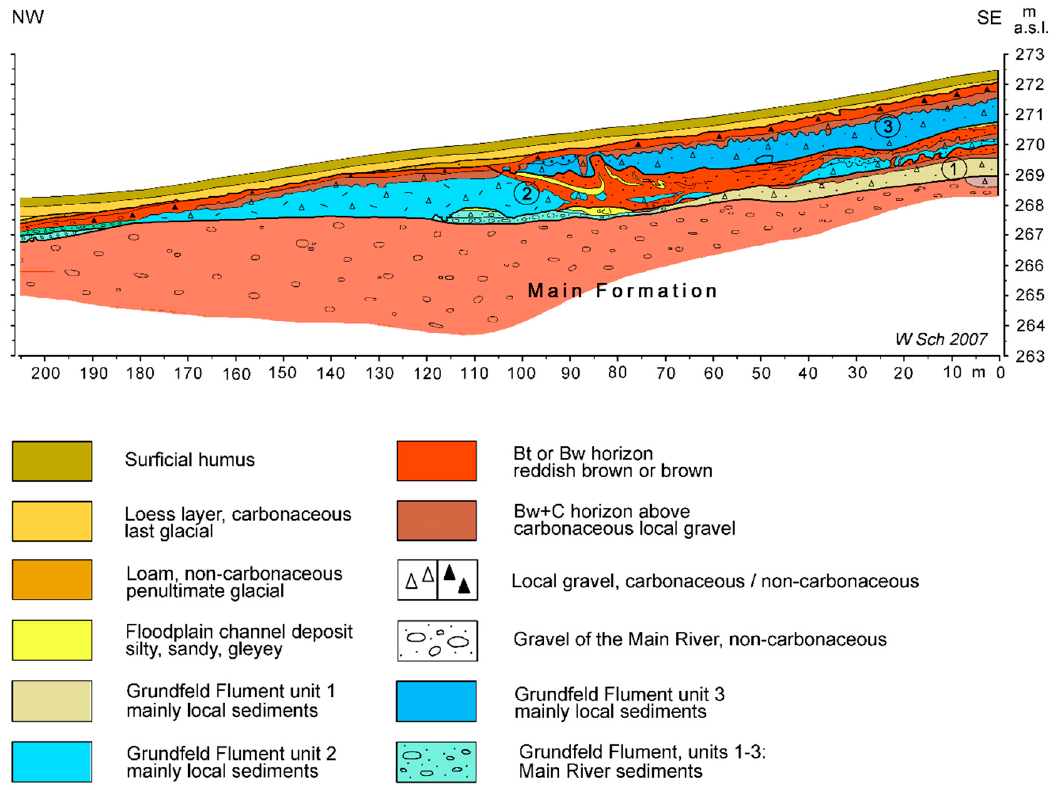
Figure 14. Grundfeld-Strassäcker gravel pit. Location: see quadrangle in Figure 13. Overlap of the Grundfeld Flument, with subunits 1–3, upon the truncated Main Formation. The colors of subunits 1–3 vary in order to contrast the three subunits, and local gravel and Main gravel (green) within the subunits.